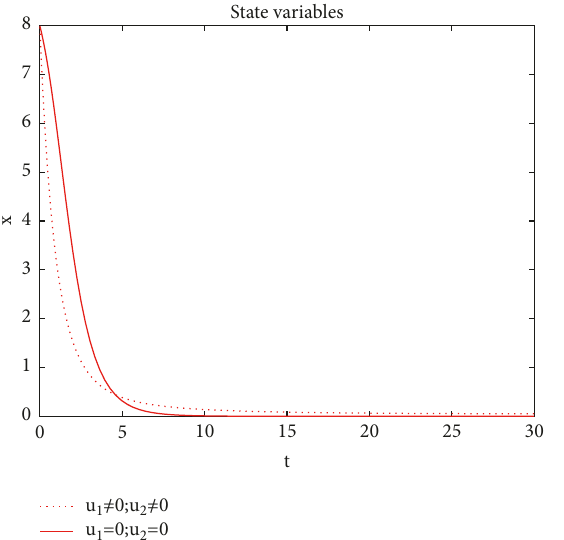
Figure 9: Evolution of number of 𝑥(𝑡) with or without control.